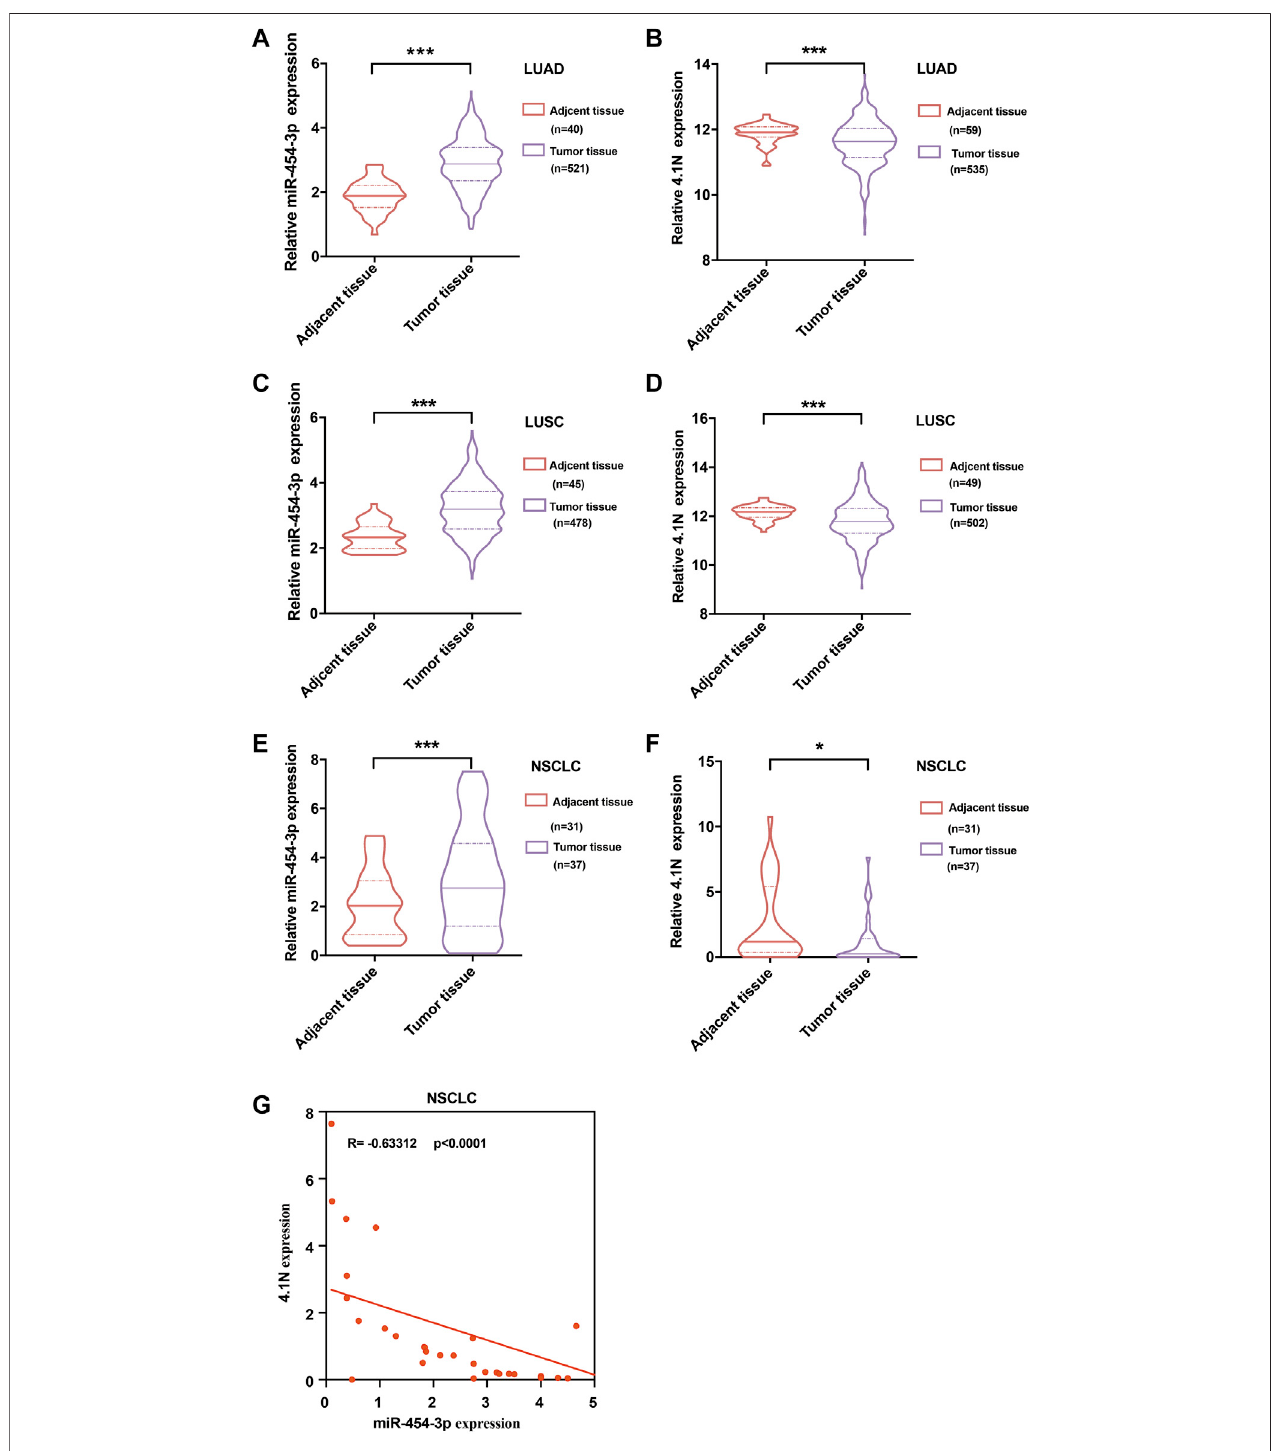
FIGURE 6 | Validation of expression patterns of miR-454-3p and 4.1N/ EPB41L1 mRNA in NSCLC. Relative expressions of miR-454-3p and 4.1N/ EPB41L1 mRNA in LUAD. (A,B) and LUSC (C,D) were analyzed using the data from the TCGA dataset. (E-F) Relative expression of miR-454-3p and 4.1N/ EPB41L1 mRNA in NSCLC and adjacent tissues was measured by qPCR. GADPH and U6 were used as loading control of 4.1N/ EPB41L1 mRNA and miR-454-3p, respectively. (G) Correlation between miR-454-3p and 4.1N/ EPB41L1 mRNA was determined using Spearman ’ s coef fi cient analysis. The data were presented as the mean ± SD. * p < 0.05 and *** p < 0.001.